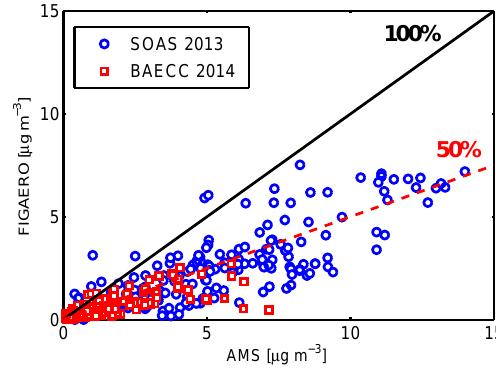
Figure 4. The relationship between calculated binding enthalpy and d V 50 is shown for compounds which were observed from the oxi- dation of α -pinene in the presence of NO x and for which quantum calculations have been performed (see Table 1). The modeled and measured relationship allows estimation of the binding energy of molecules which are too complex or computationally intensive to calculate. Also shown in red is a linear least-squares fit to the data ( R 2 = 0 . 9).